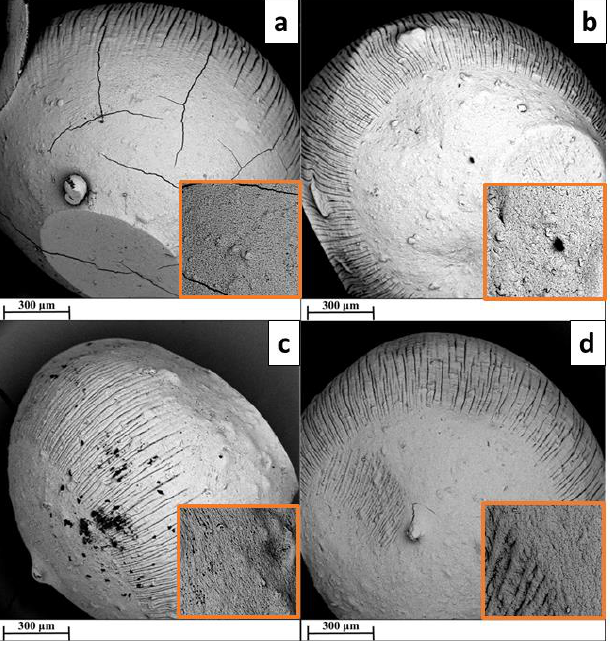
Figure 3. SEM micrographs of B-PE beads ( a ) B-PE-0, ( b ) B-PE-2.5; ( c ) B-PE-10 and ( d ) B-PE-20.